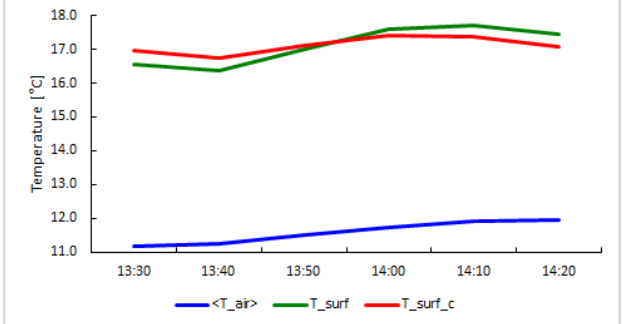
Figure 4. From air temperature (< T air >) and surface temperature ( T surf ), the resultant T surf _ c from the campaign on 11 April 2018, 13:30–14:20 CET. At 13:55, the surface temperature is higher